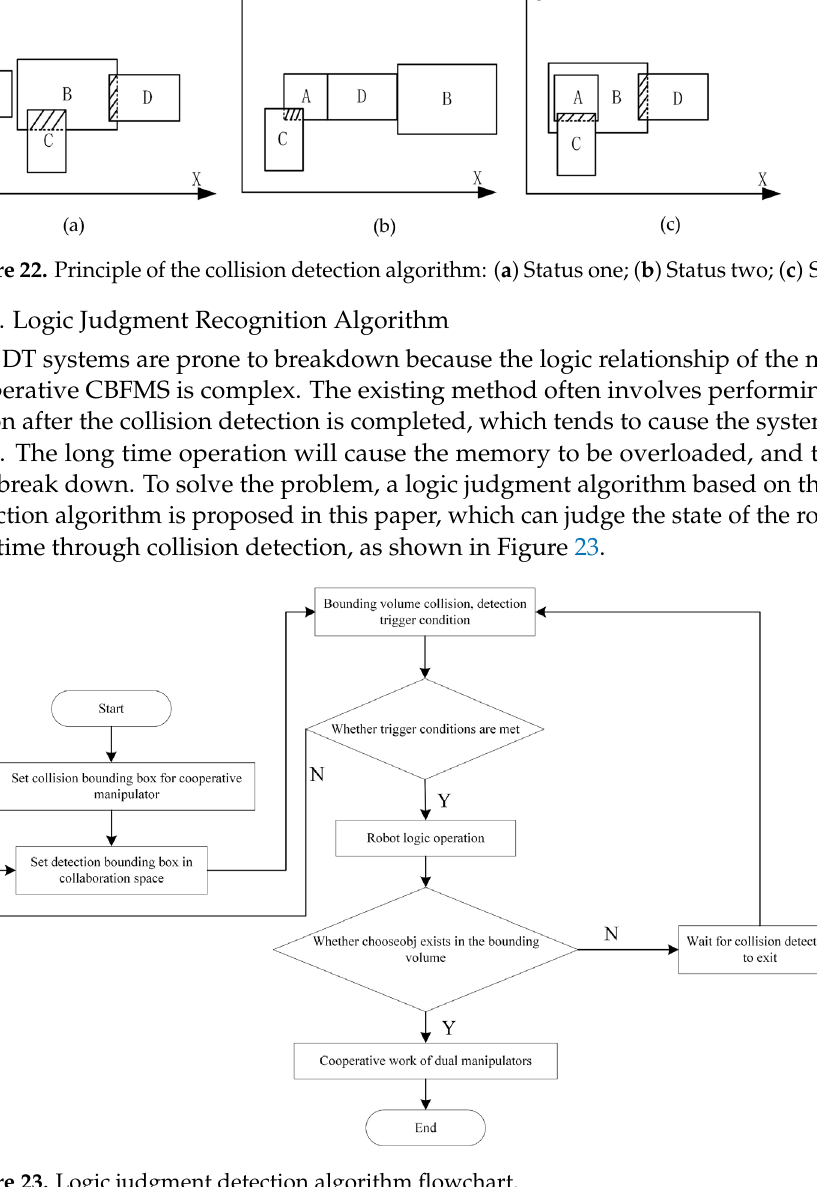
Figure 23. Logic judgment detection algorithm flowchart.